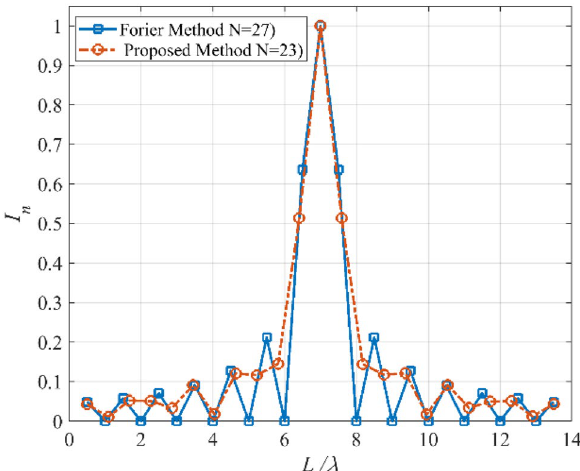
Figure 7. The obtained I n ’s of the second case.